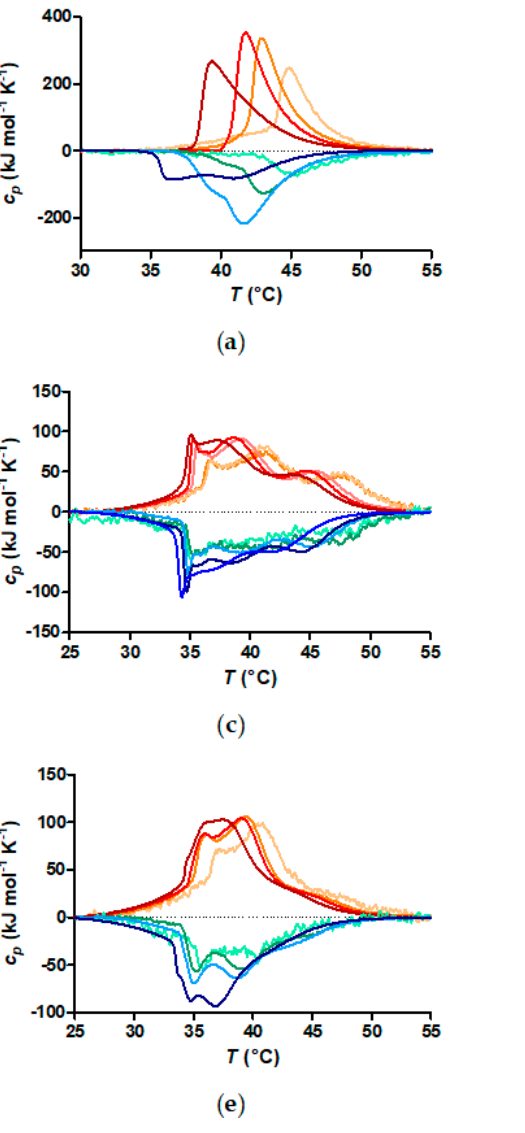
Figure 5. Dynamic scanning calorimetry (DSC) curves of free polymer and core-shell nanoparticles, orange-red: heating curves and green-blue: cooling curves. ( a ) Free polymer: light orange and light green: 0.1 g L − 1 , orange and green: 0.5 g L − 1 , red and blue: 1 g L − 1 and dark red and dark blue: 10 g L − 1 ; ( b ) FeOx-5: light orange and light green: polymer concentration: 0.06 g L − 1 , orange and green: polymer concentration: 0.1 g L − 1 , light red and light blue polymer concentration: 0.5 g L − 1 , red and blue: polymer concentration: 1 g L − 1 and dark red and dark blue: polymer concentration: 10 g L − 1 ; ( c ) FeOx-7: light orange and light green: polymer concentration: 0.1 g L − 1 , orange and green: polymer concentration: 0.112 g L − 1 , light red and light blue polymer concentration: 0.5 g L − 1 , red and blue: polymer concentration: 1 g L − 1 and dark red and dark blue: polymer concentration: 10 g L − 1 ; ( d ) FeOx − 10: light orange and light green: polymer concentration: 0.1 g L − 1 , orange and green: polymer concentration: 0.28 g L − 1 , light red and light blue: polymer concentration: 0.5 g L − 1 , red and blue: polymer concentration:1 g L − 1 and dark red and dark blue: polymer concentration: 10 g L − 1 ; ( e ) FeOx-21: light orange and light green: polymer concentration: 0.1 g L − 1 , orange and green: polymer concentration: 0.5 g L − 1 , red and blue: polymer concentration:1 g L − 1 and dark red and dark blue: polymer concentration: 10 g L − 1 .